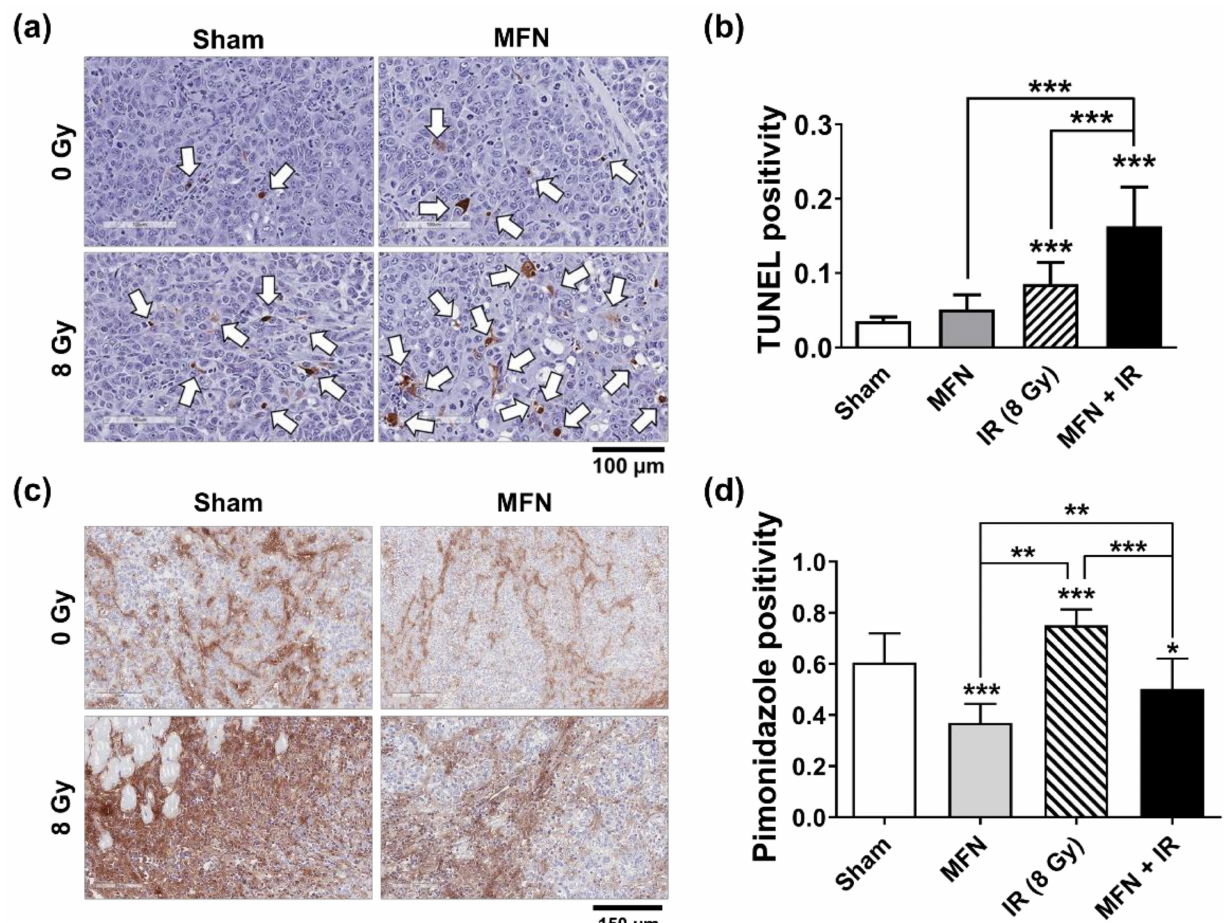
Figure 5. In vivo assessment of apoptosis and hypoxia status in Hepa1-6 tumor tissues following treatment with ionizing radiation (IR) and/or MnFe 2 O 4 nanoparticles (MFN) in a mouse model. ( a ) Representative TUNEL staining images of the Hepa1-6 tumor tissues. Tumors were harvested on day 30. The white arrows indicate TUNEL-positive cells. ( b ) Quantitative comparison of TUNEL positivity among the experimental groups. The combination of IR and MFN significantly promoted apoptosis in tumor tissues. ( c ) Representative images of pimonidazole staining (brown color) showing an MFN- dependent decrease in hypoxia in Hepa1-6 tumor tissues. ( d ) Quantitative comparison of the pimonidazole levels among the experimental groups. The values represent the mean ± SD; * p < 0.05; ** p < 0.01; *** p <